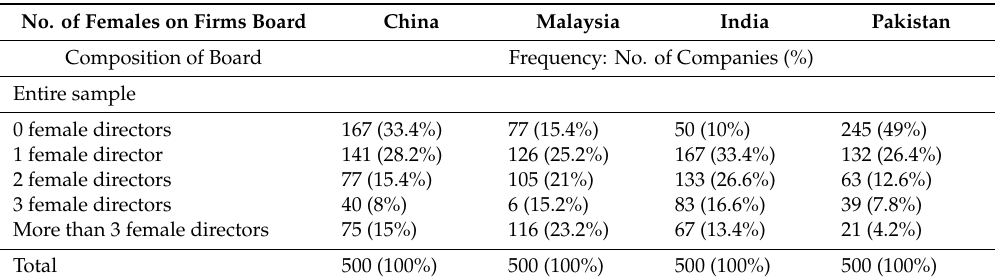
Table 2. Presence of female directors in Asian emerging economies (in the years 2017–2018).